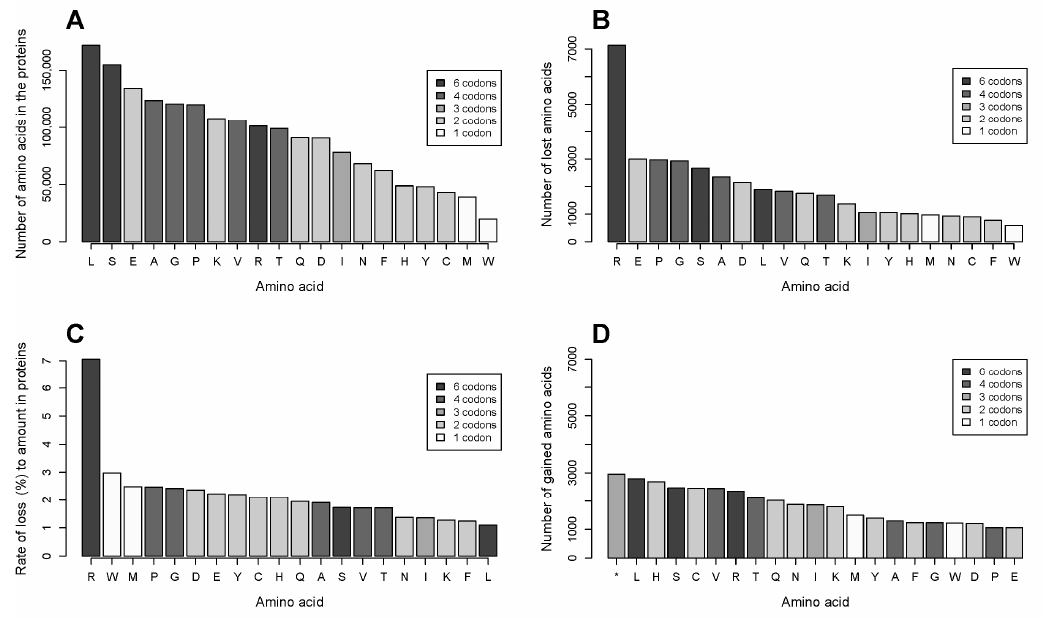
Figure 2. Amino acid composition of the analyzed set of proteins and substitutions in the proteins in the CCLE database. ( A ) Amino acid content in the 2164 proteins. In this and the following graphs, the bars are colored by the number of codons that code for each amino acid: amino acids are denoted with a one-letter code, and truncation is denoted as “*”. ( B ) Frequencies of loss of amino acids due to mutations in the analyzed proteome subset in the 782 cancer cell lines. ( C ) Rate of loss for each amino acid. It is calculated as the ratio of the number of the substitution events for an amino acid in the CCLE database to its amount in the 2164 proteins. ( D ) Frequencies of gain of amino acids due to mutations in the analyzed proteome subset in the 782 cancer cell lines.